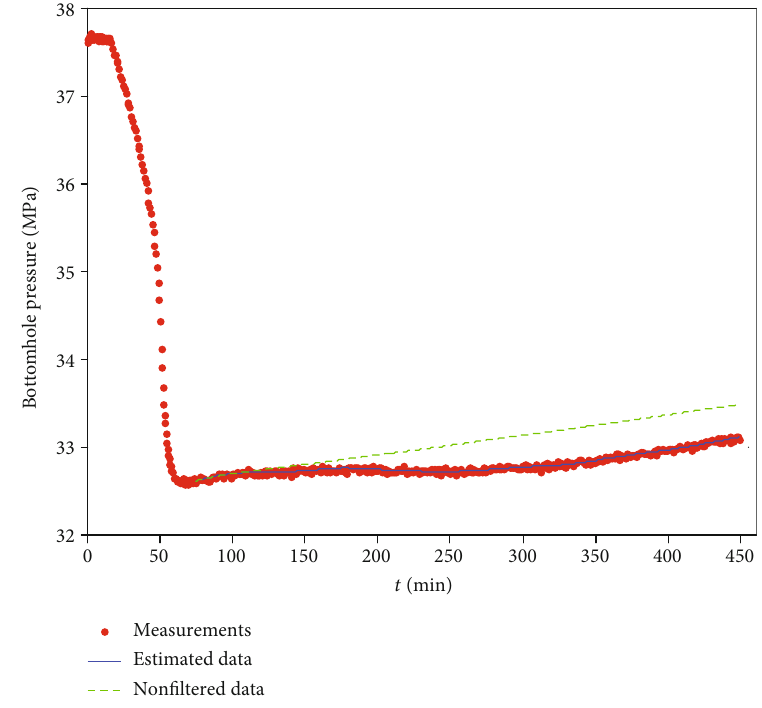
Figure 3: Bottomhole pressure variation (case